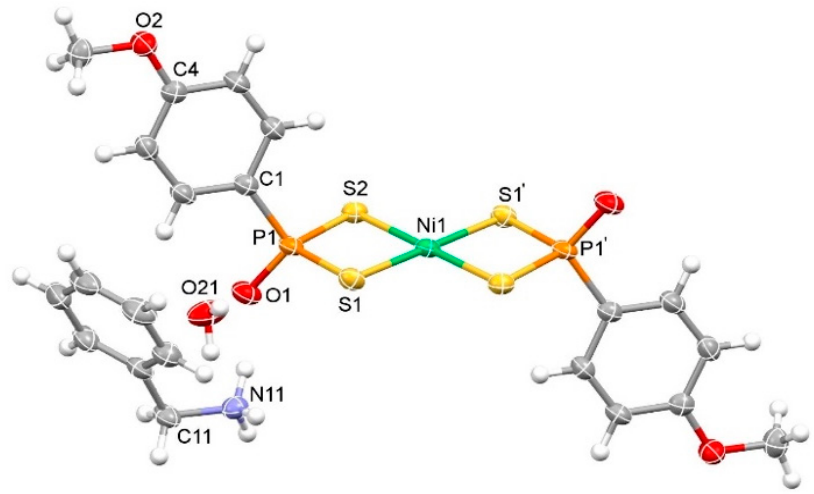
Figure 2. Ellipsoid plot (50% probability level) and numbering scheme for (BzNH 3 ) 2 [Ni(dtp) 2 ] · 2H 2 O. Only one cation and one water molecule are depicted for clarity. Symmetry code: ' = 1-x, -y, 2-z.